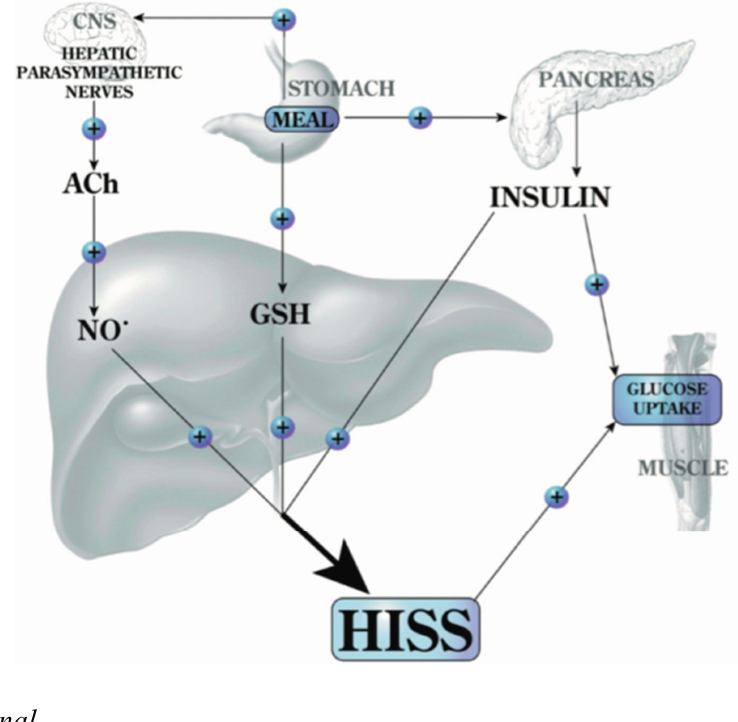
Figure 6. Feeding signals for HISS release. Feeding results in an increase of hepatic glutathione (GSH) and a parasympathetic signal to the liver that acts, via acetylcholine (ACh), on muscarinic receptors to activate NO release. Both of these signals are permissive and both are needed in order for insulin to cause the release of HISS. HISS acts selectively on skeletal muscle (recently also shown to act on heart and kidney [19]). Blockade of any portion of these pathways leads to blockade of HISS release and a state of HISS-dependent insulin resistance. HISS release is physiologically regulated to be absent in the fasted state, but when HISS release is not activated by feeding, its absence is suggested to account for postprandial hyperglycemia, hyperinsulinemia, hyperlipidemia, and increased oxidative stress. Chronic lack of HISS action results in a progressive and predictable series of homeostatic dysfunctions typical of type 2 diabetes ([8], © Canadian Science Publishing or its